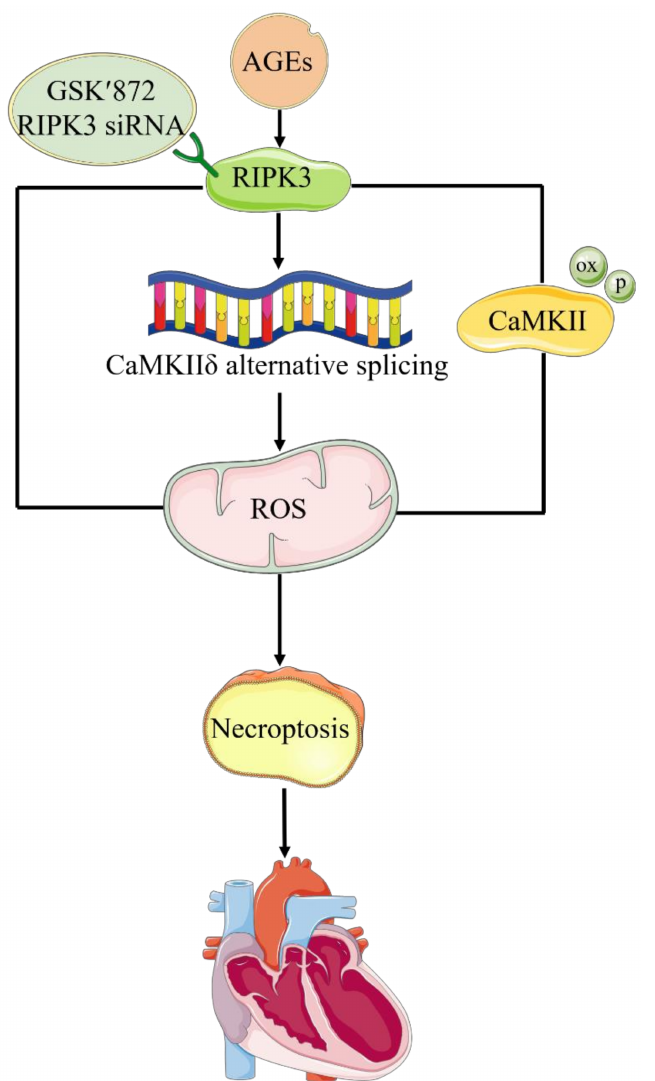
Figure 15. Mechanism of AGEs-induced necroptosis in cardiomyocytes. AGEs increased the ex- pression of RIPK3, aggravated the disorder of CaMKII δ alternative splicing, promoted CaMKII activation, enhanced oxidative stress, induced necroptosis, and damaged cardiomyocytes. RIPK3 downregulation or RIPK3 inhibitor GSK (cid:48) 872 corrected CaMKII δ alternative splicing disorder, inhib- ited CaMKII activation, reduced oxidative stress, attenuated necroptosis, and improved cell damage in